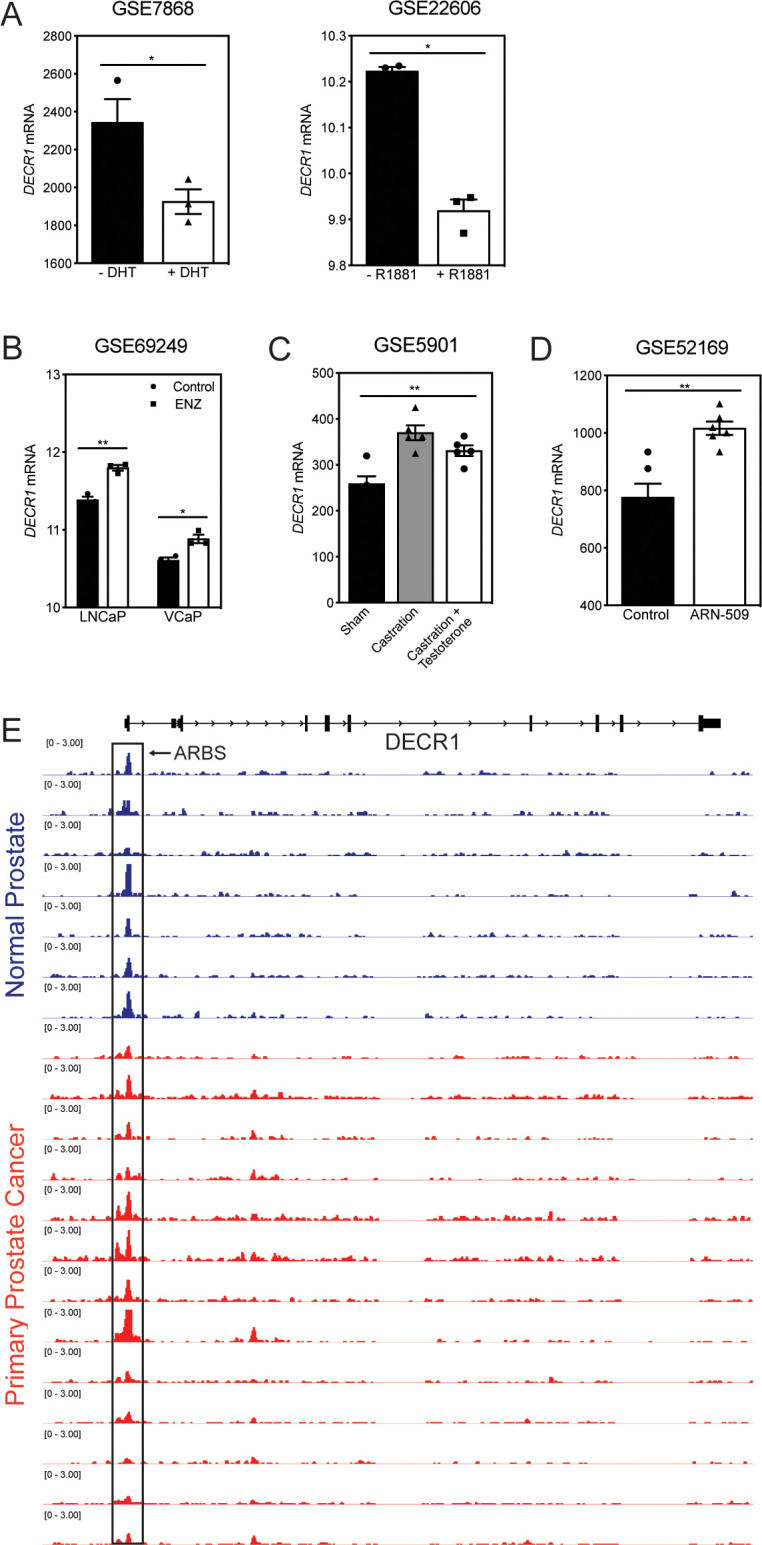
Androgenic regulation of DECR1 expression.(A) Bar graphs of DECR1 mRNA expression in two publically available datasets shows DECR1 mRNA expression decreased after LNCaP treatment with DHT (GSE7868) or R1881 (GSE22606). (B) DECR1 expression increased in LNCaP and VCaP upon treatment with Enzalutamide (GSE69249). (C) DECR1 mRNA expression increased in mouse prostate gland after castration but decreased after testosterone administration. (D) ARN-509 (Apalutamide) treatment of LNCaP/AR xenograft increased DECR1 mRNA expression (GSE52169). (E) AR ChIP-sequencing data from normal human prostate and primary human prostate tumor specimens (normal, n = 7; tumor, n = 13). Data from GSE56288. Statistical analysis was performed using two-tailed Student’s t-test: *p<0.05, **p<0.01 and ****p<0.0001.